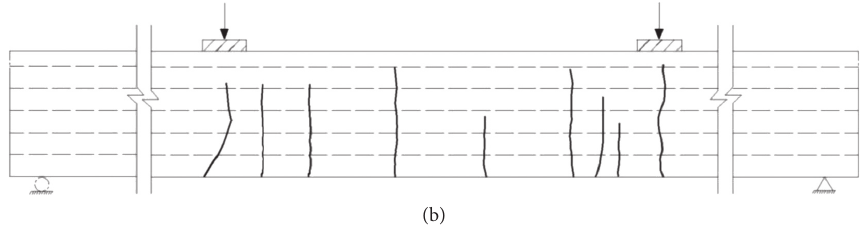
Figure 11: Fatigue failure shape and crack distribution of JP2 beam: (a) failure shape; (b) crack distribution.